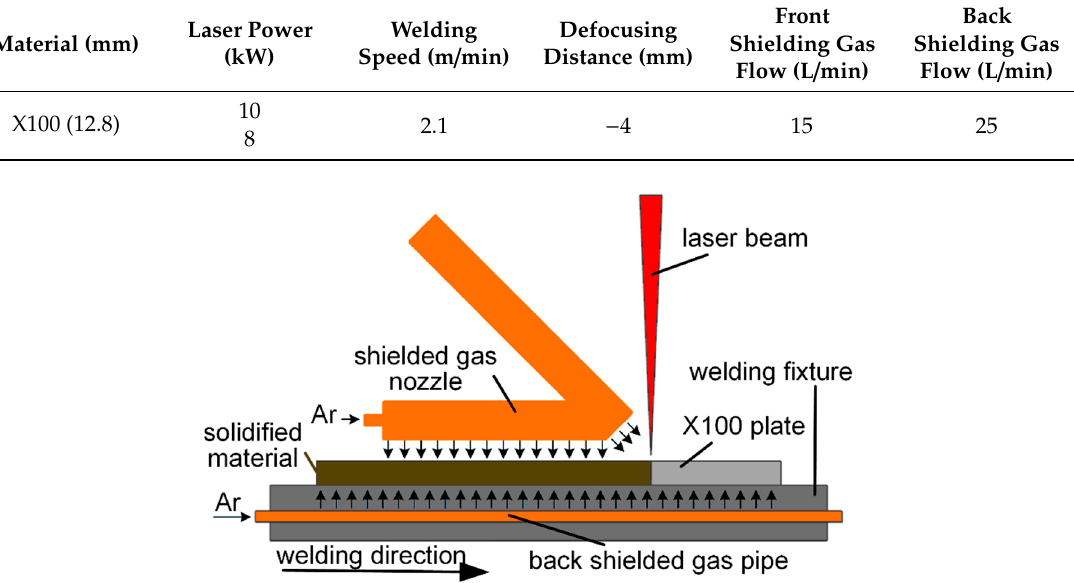
Figure 2. Schematic of the X100 laser-welding device. Table 2. Parameters of the X100 pipeline steel laser welding process.